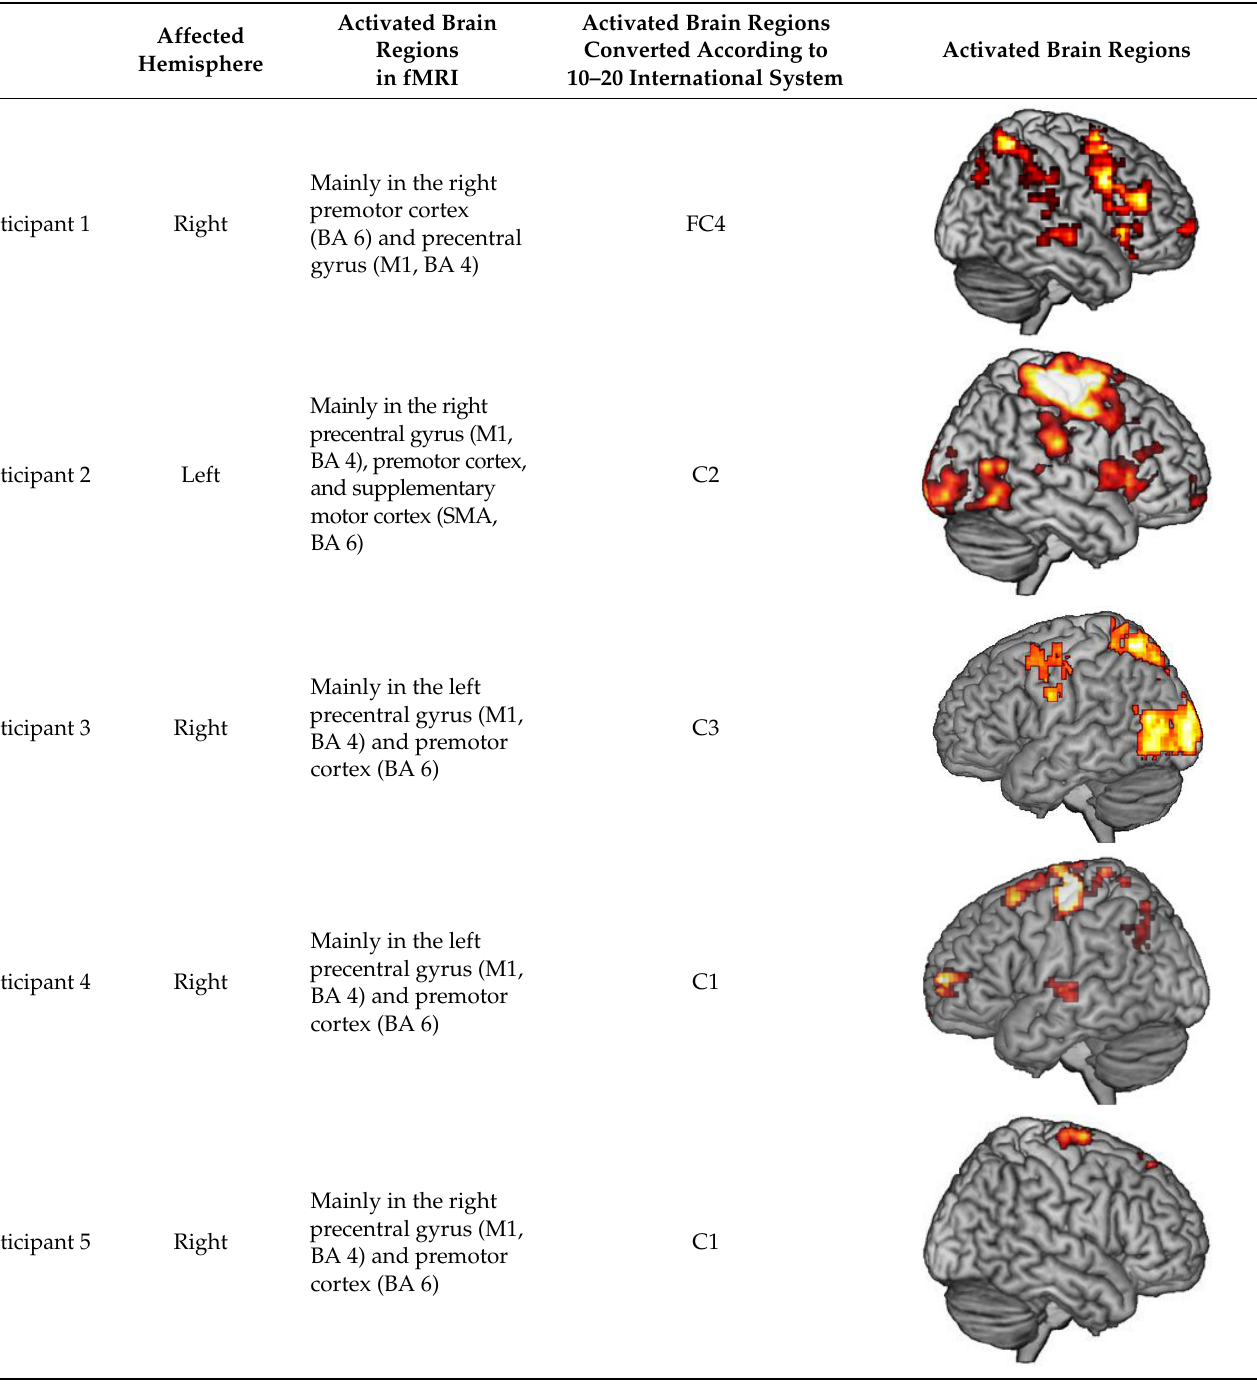
Table 3. Behavioural Outcome